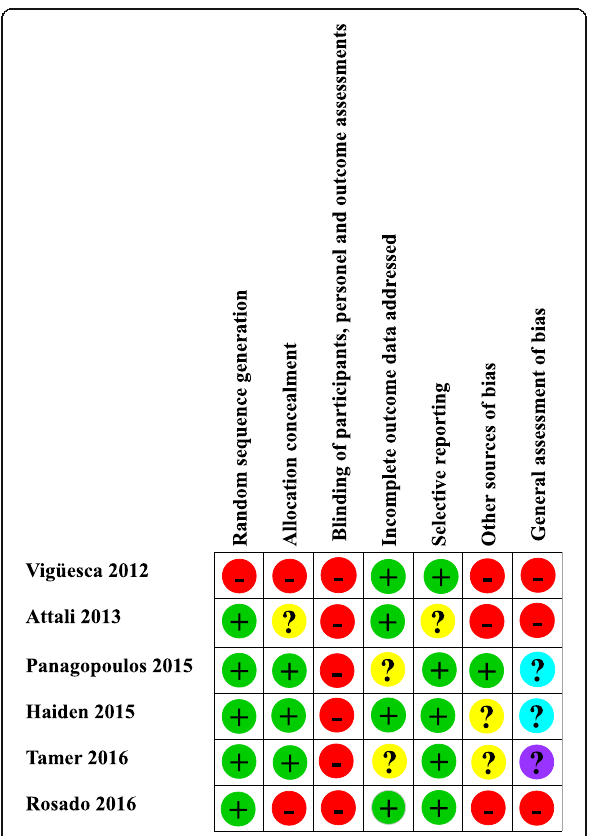
Fig. 5 Assessment of methodological risk of bias for each efficacy studies included. Green shading indicates a low risk of bias, yellow an unclear risk of bias and red a high risk. Grey shading color indicates non-applicable items. For general assessment of bias, purple shading and cyan shading indicates a major doubt and a minor doubt as to the overall risk of bias, respectively